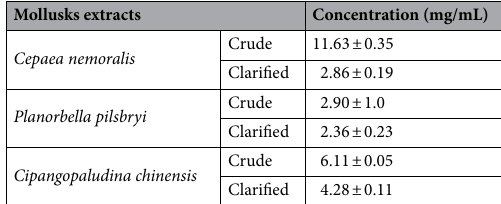
Table 1. Protein concentration determination for mollusk